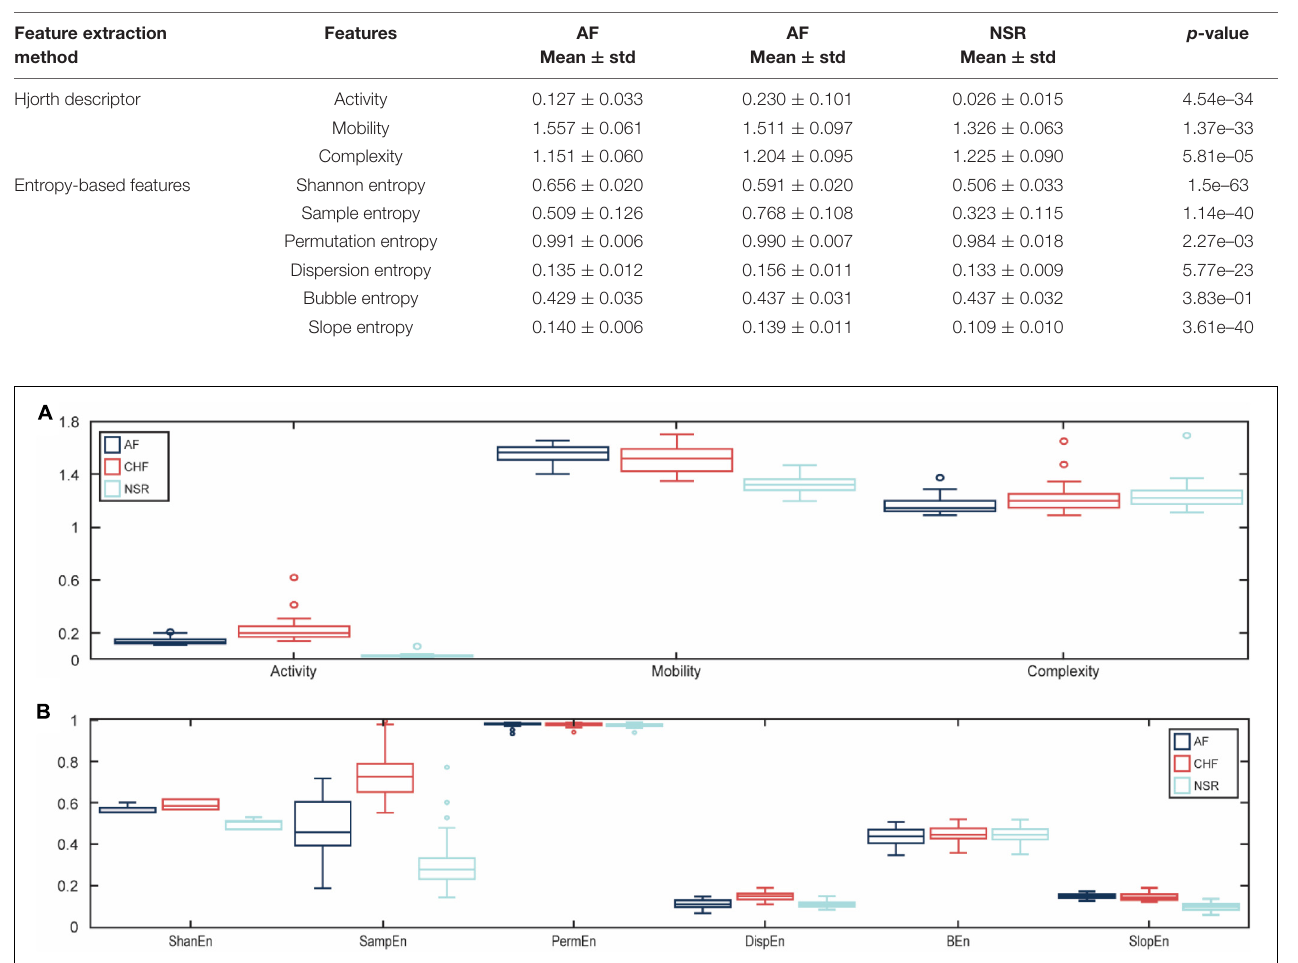
FIGURE 3 | The boxplot distributions for each feature. The distribution value of Hjorth descriptor features for atrial fibrillation (AF), congestive heart failure (CHF), and normal sinus rhythm (NSR) conditions (A) and the distribution value of entropy-based features for AF, CHF, and NSR conditions (B) .